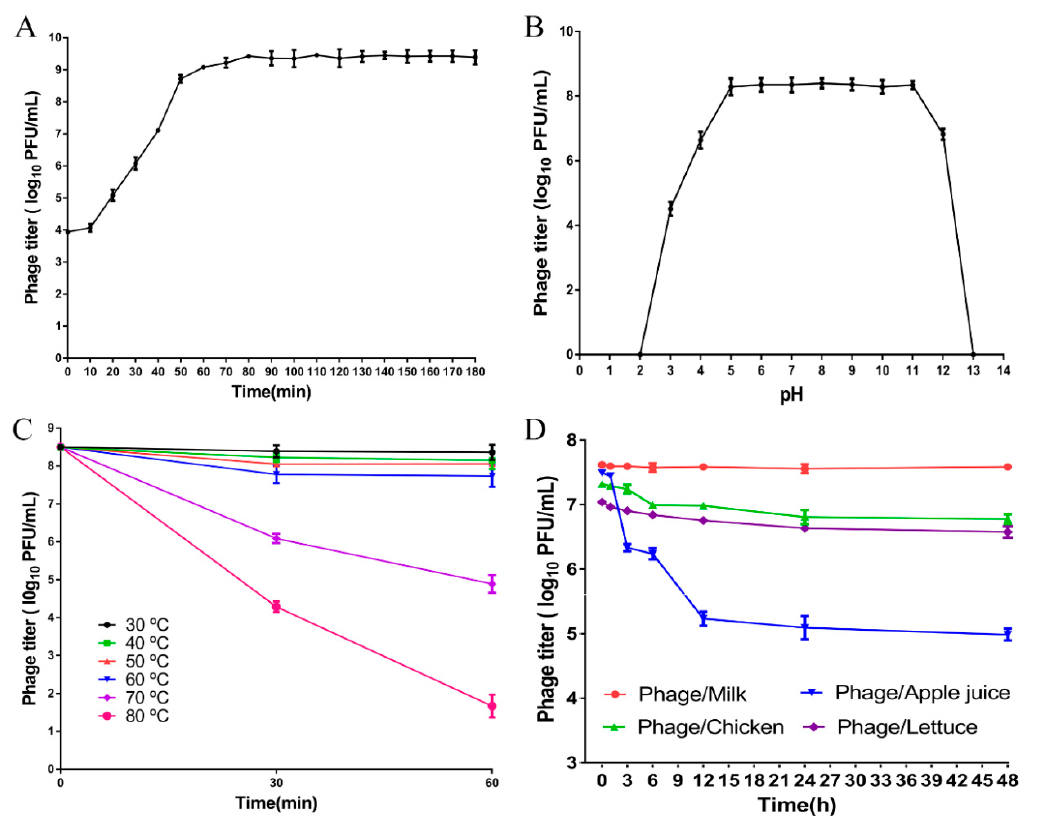
Figure 3. Characteristics of phage LPST94. ( A ) One-step growth curves of phage LPST94 with Salmonella enterica serovar Typhimurium UK-1 host infected at 37 ◦ C, ( B ) pH tolerance of phage LPST94 (pH 2 to 13), ( C ) Temperature tolerance of phage LPST94 (30 ◦ C to 80 ◦ C), and ( D ) Stability of phage LPST94 in four food samples (milk, apple juice, chicken breast, and lettuce) at 25 ◦ C. Values represent mean with standard deviation of three determinations of each point.